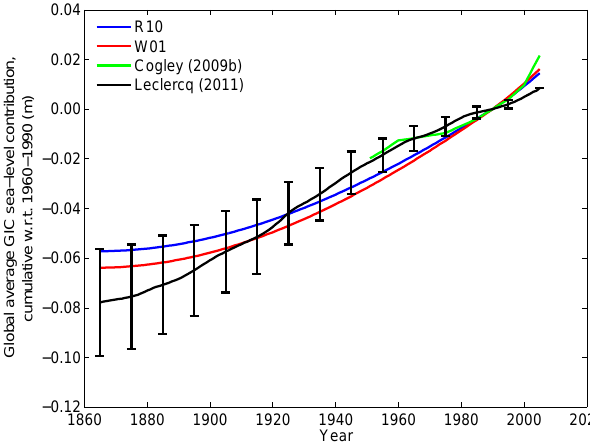
Fig. 2. Global average GIC sea-level contribution (m) relative to 1990. (green line) and the estimated GIC contribution of Leclercq et al. (2011) (black line). The latter is a global reconstruction of glacier length records back to 1800 using volume-length scaling ( Bahr et al., 1997; Oerlemans et al., 2007). Note that the total area differs between the data sets: Cogley (2009b) uses 785 000 km 2 , Leclercq et al. (2011) use 704 000 km 2 (both include Antarctic glaciers), W01 has a surface area of R10 and W01 exclude Antarctic